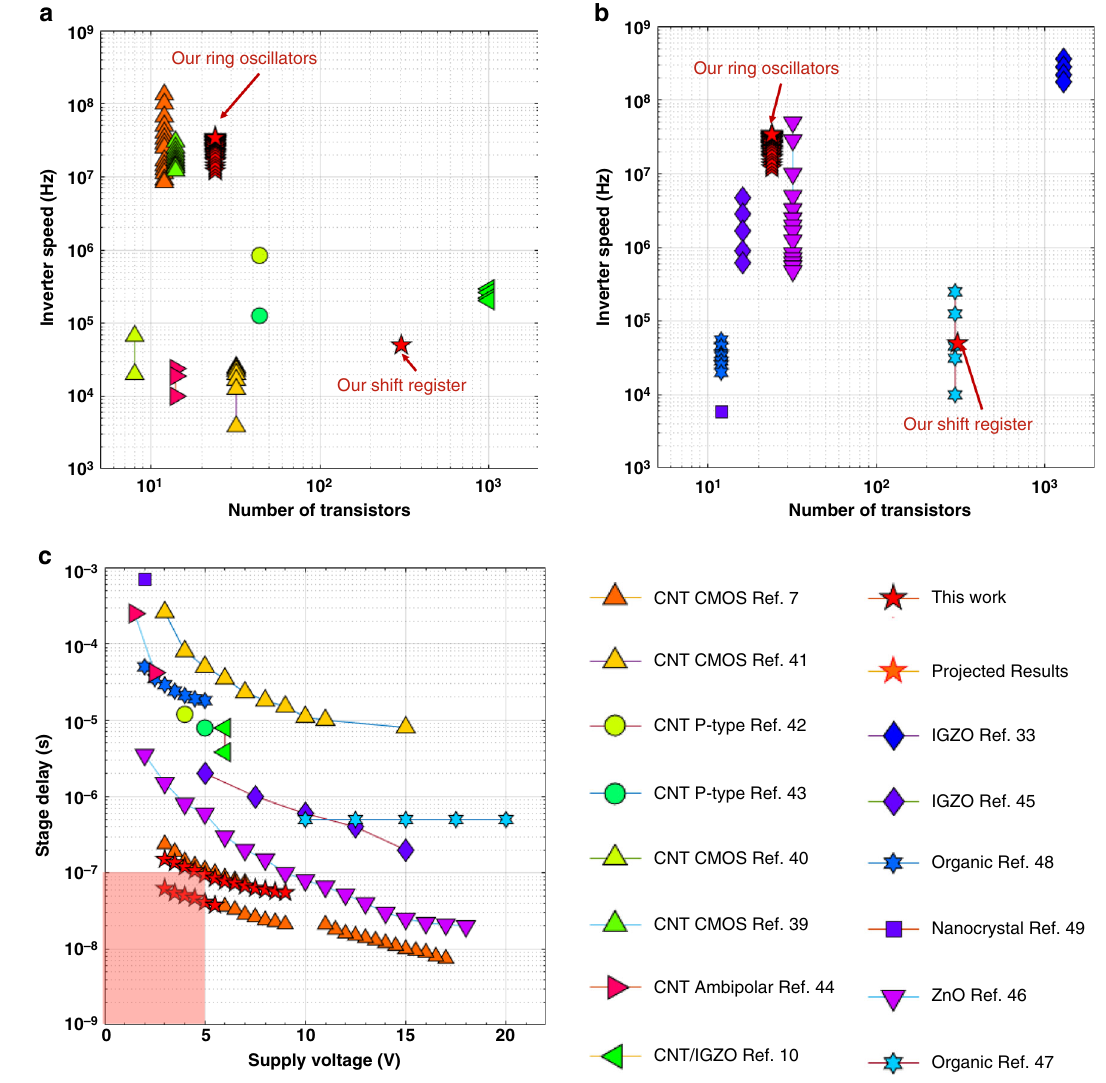
Fig. 5 Comparison of the circuit performance and complexity of various fl exible TFT circuits. a Comparison of mono-type, complementary, ambipolar, and hybrid CNT-based fl exible circuits 7,10,39 – 44 . The inverter speed is de fi ned as 1/(stage delay) and the number of transistors represents the achieved circuit complexity. b Comparison of state-of-the-art metal oxide, organic and nanocrystal-based fl exible circuits 33,45 – 49 . c Comparison of stage delay among representative fl exible ring oscillators 7,10,40 – 49 . To enable fair comparisons, we compared our fl exible circuits with recent published results on fl